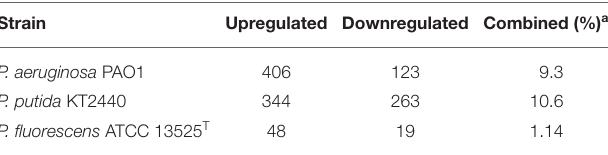
TABLE 1 | The quantity of DEGs in P. aeruginosa PAO1, P. putida KT2440, and P. fluorescens ATCC 13525 T . Strain Upregulated Downregulated Combined (%)